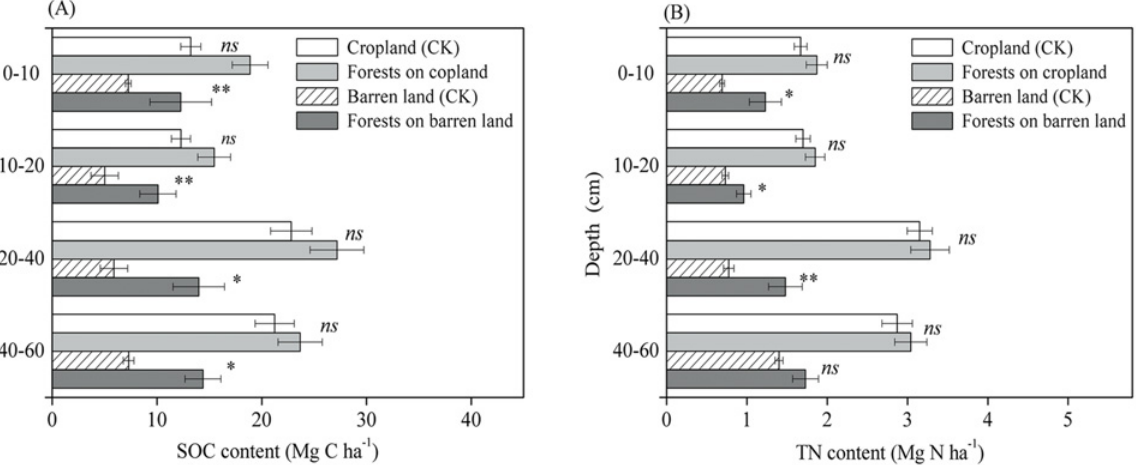
Fig 3. Comparing the mean soil SOC (A) and soil TN (B) contents in afforested and reference (CK) plots at different soil layers across multiple sites on the Qinghai Plateau. The symbols of ** , * and ns indicate the levels of significant differences between reference and afforested plots at < 0.01, < 0.05 and > 0.05, respectively.